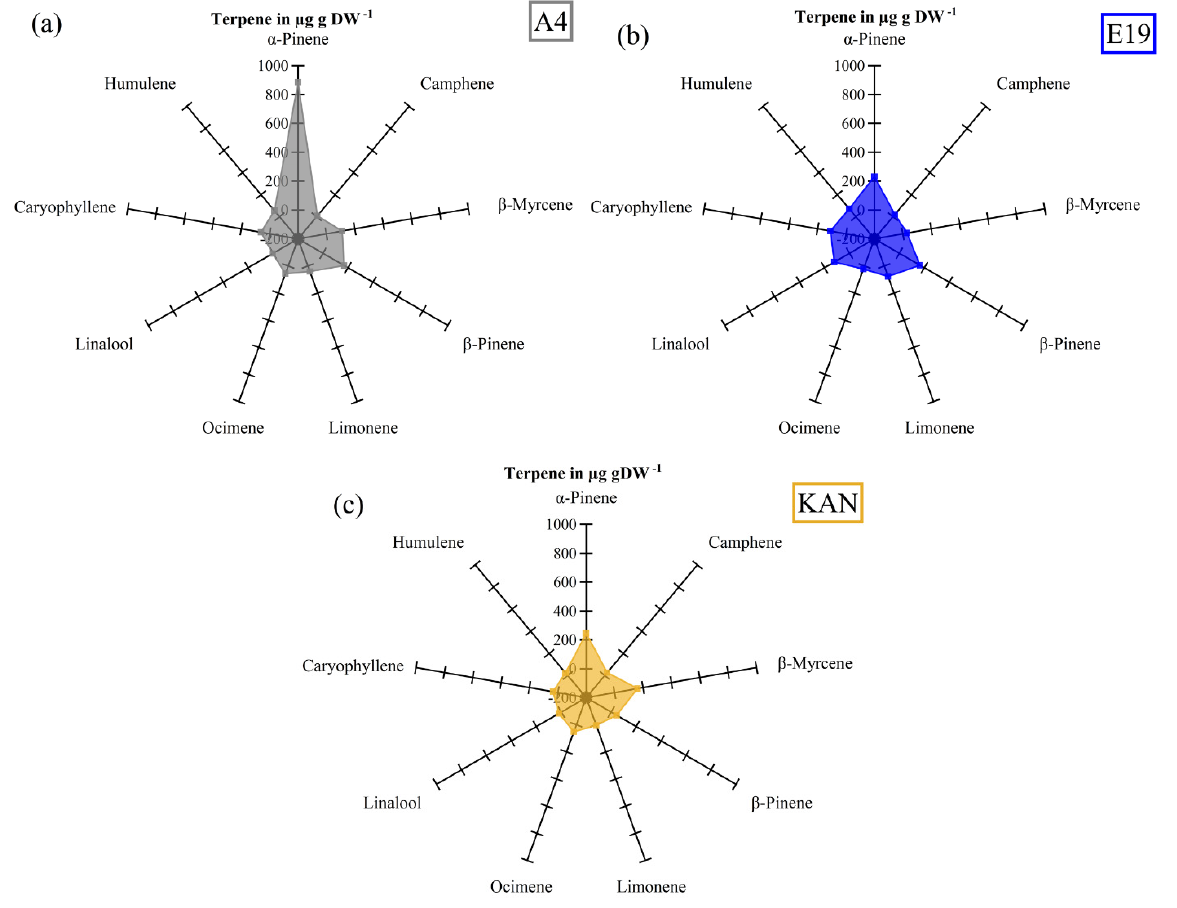
Figure 4. Radar chart of the terpene profile for the three strains: A4 ( a ), E19 ( b ) and KAN ( c ). Additionally, the terpenes exhibited significant two-way interactions between light, strain and flower position. The results are therefore presented separately for the different interactions.